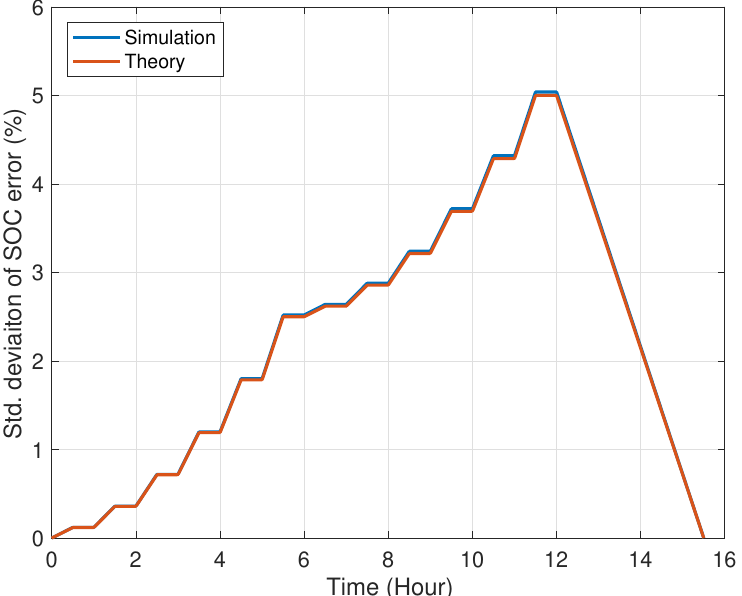
Figure 13. The standard deviation of SOC error due to uncertainty in battery capacity. The red curve is the theoretical value of the s.d. σ s,C ( k ) derived in (59); the blue curve shows ˆ σ s,C ( k ) , the s.d. obtained through the Monte Carlo simulation as shown in (94). Due to the approximation made in (51), the theoretical and simulated values slightly